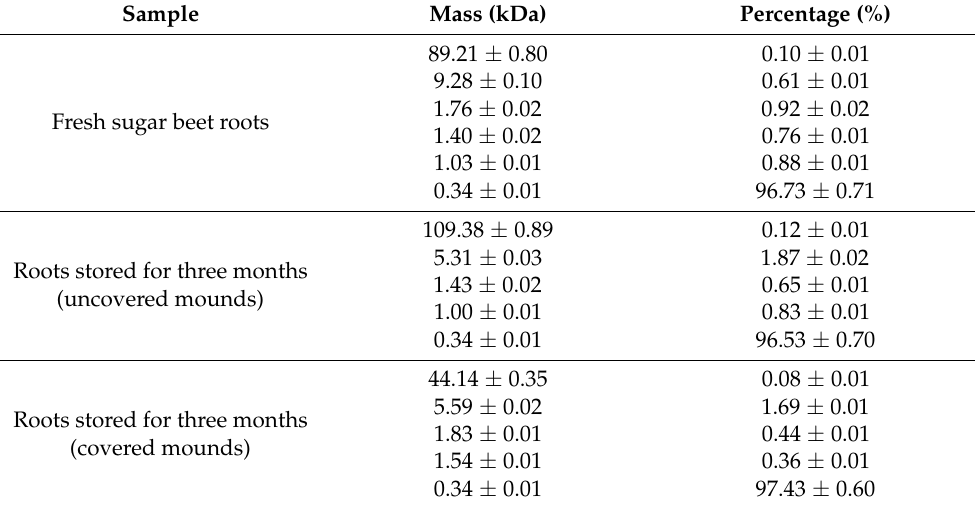
Table 3. Molecular masses of carbohydrates after hydrolysis of complex carbohydrates in sugar beet roots.